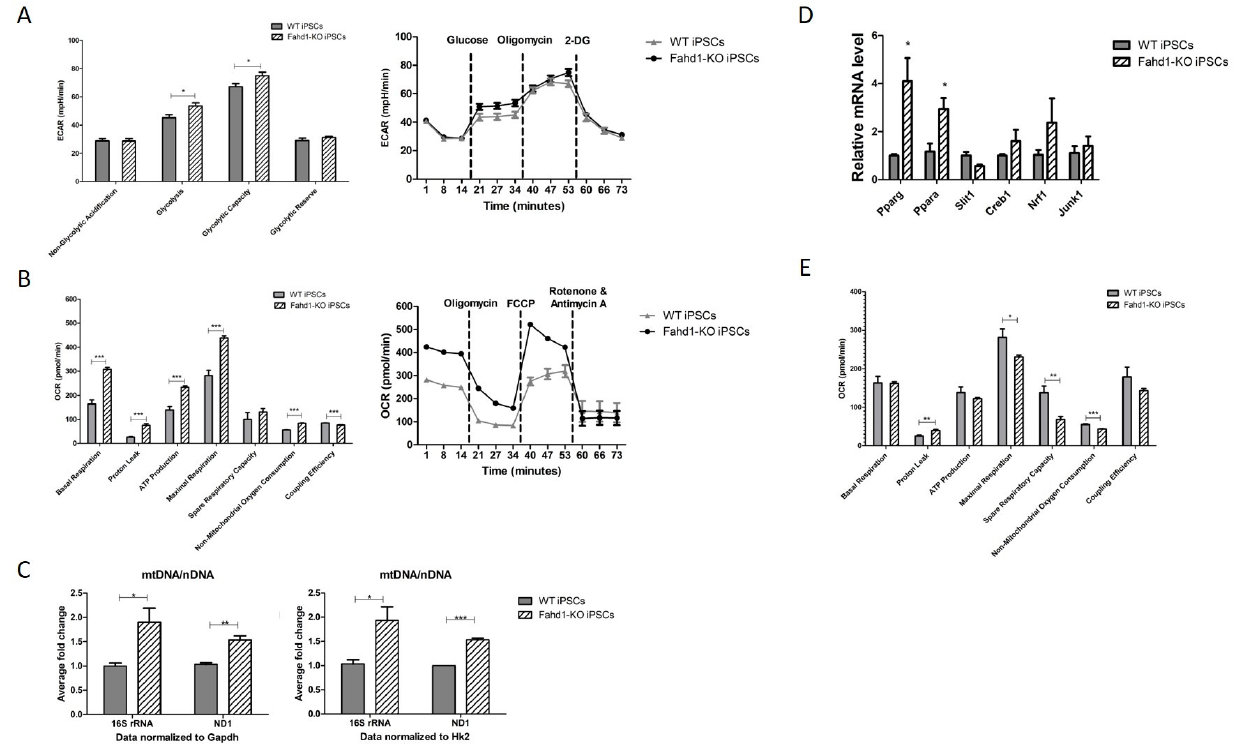
Figure 4. Mitochondrial remodeling during reprogramming is affected by Fahd1 deficiency. ( A ) ECAR measurements in mpH/min using the Seahorse XFp analyzer and following glycolysis stress test protocol showed that basal glycolysis, as well as glycolytic capacity, were weakly but significantly increased in Fahd1-KO iPSCs as compared to WT, * p < 0.05, n = 3. ( B ) OCR measurements in pmol/min using the Seahorse XFp analyzer and following MitoStress test protocol showed a significant increase of OCR for almost all parameters in Fahd1-KO iPSCs, *** p < 0.001, n = 3. ( C ) Average fold-change of mtDNA/nDNA ratio showing the relative concentration of mitochondrial vs. nuclear DNA, determined by qPCR amplification using primers for the mt genes coding for 16S rRNA and ND1, respectively, which were separately normalized to nuclear DNA amplified using primers for nuclear genes Gapdh and Hk2. qPCR analysis was performed in WT and Fahd1-KO iPSCs, as indicated, * p < 0.05, ** p < 0.01, *** p < 0.001, n = 3. ( D ) Relative mRNA expression of markers known to be involved in mt biogenesis, Pparg, Ppara, Slit1, Creb1, Nrf1, and Junk1. Their mRNA expression was evaluated in WT and Fahd1-KO iPSCs. Pparg and Ppara mRNA expression was significantly increased in Fahd1-KO iPSCs compared to WT, * p < 0.05, n = 3. ( E ) OCR normalized to mitochondrial copy number was slightly higher in WT vs. Fahd1-KO iPSCs, * p < 0.05, ** p < 0.01, *** p < 0.001, n = 3. iPSCs: induced pluripotent stem cells, WT: wild type, KO: knock-out,